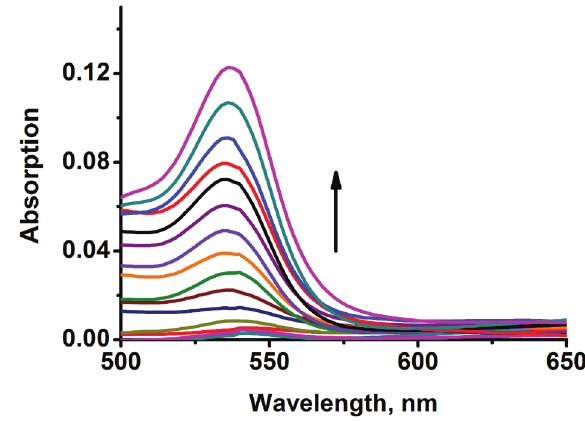
Figure 2 : Absorption spectra of sensor Rh6G-1 (10 μM) in the presence of increasing concentrations of Fe 3+ (0 - 50 equiv.) in water (containing 1% DMSO as a cosolvent).